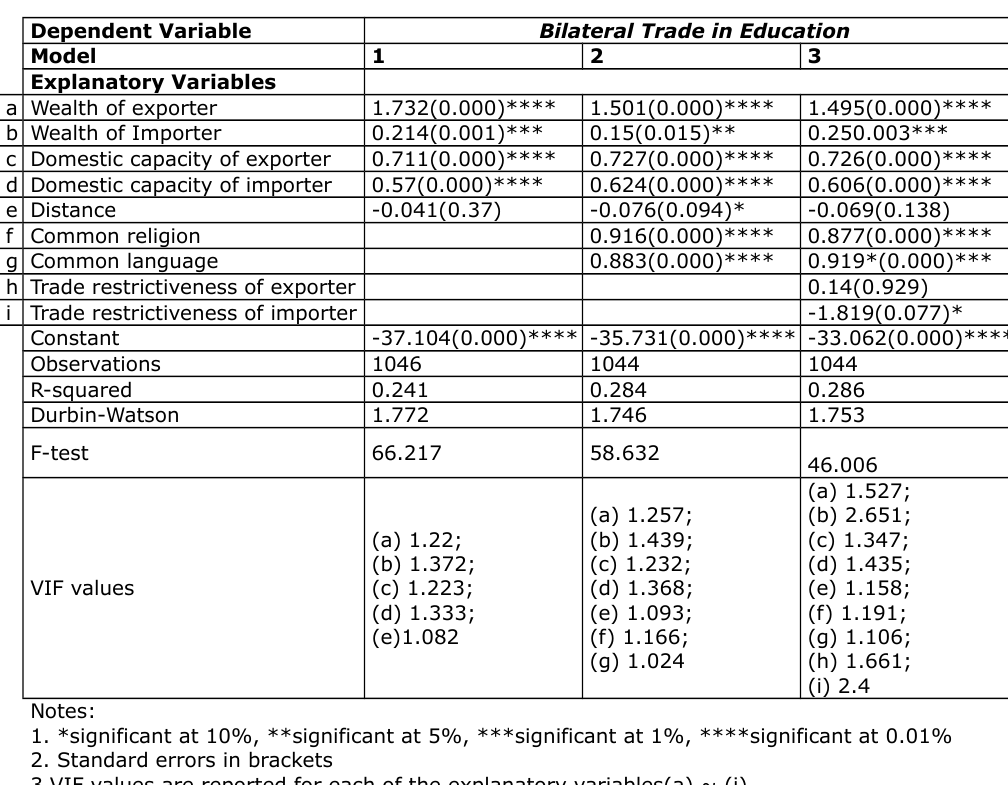
Table 1. Panel Regression Results for Ordinary Least Squares using the Random Effects